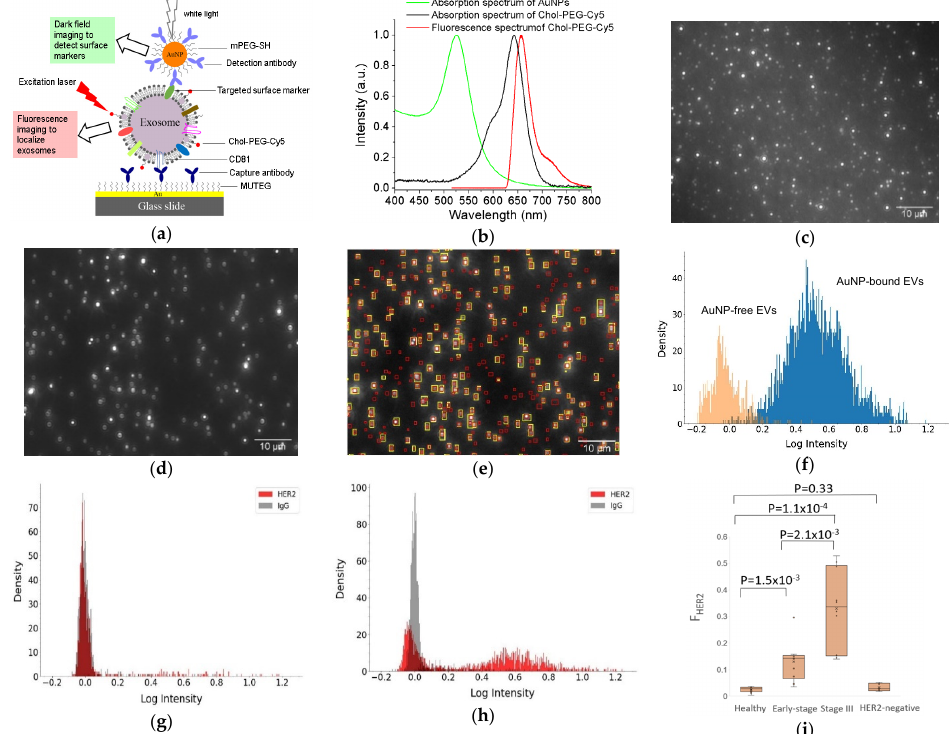
Figure 3. DISVT for surface protein detection of single EVs. ( a ) Schematic of the DISVT principle showing exosome capture with CD81 antibodies, membrane labeling with lipophilic Chol–PEG − Cy5, and surface protein labeling with antibody-conjugated AuNPs. ( b ) Optical properties of AuNPs and Chol–PEG − Cy5. ( c ) Fluorescence image of CD81 − captured plasma EVs from a stage III HER2-positive breast cancer patient after dual labeling with Chol–PEG − Cy5 and HER2/AuNPs. ( d ) Dark field image of ( c ). ( e ) Superimposed image of ( c ) and ( d ) showing AuNP-bound EVs (overlapped red and yellow labels) and AuNP − free EVs (red labels only). ( f ) EV population density histogram showing the AuNP − bound EVs (blue peak) and AuNP − free EVs (orange peak). ( g ) EV population density histogram of EVs from a stage I HER2 − positive breast cancer patient. ( h ) EV population density histogram of EVs from a stage III HER2 − positive breast cancer patient. ( i ) Box plot showing the diagnostic potential of DISVT for early detection of HER2 − positive breast cancer (n = 10 for each group). Reprinted with permission from [68]. Copyright (2023) American Chemical